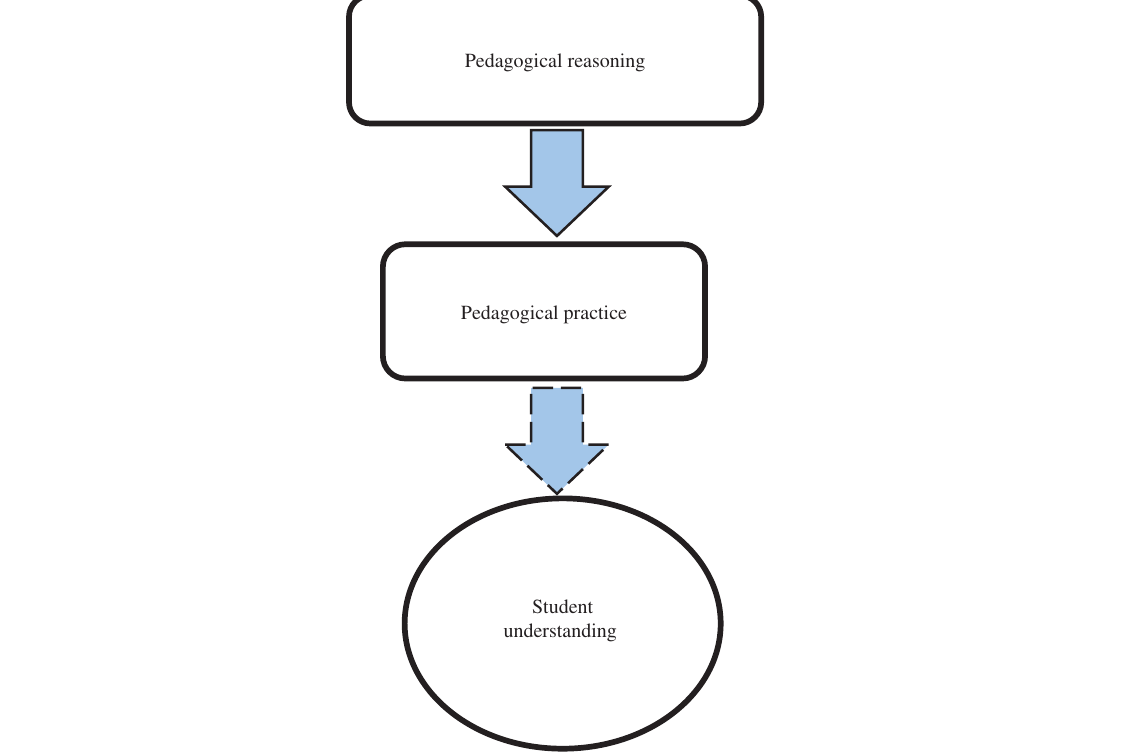
Figure 1: Hypothetical interaction between teacher reasoning and